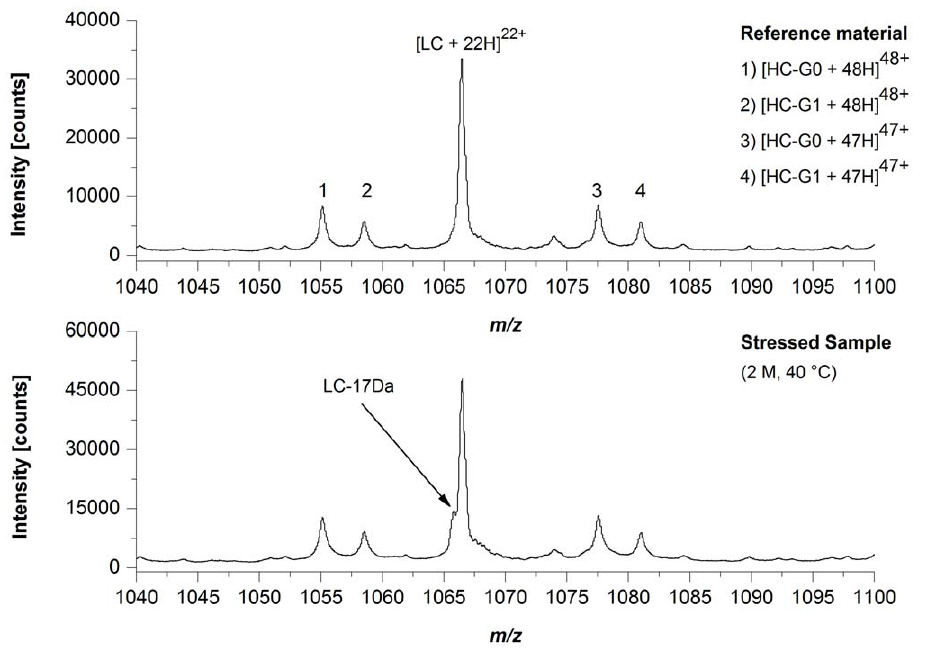
Figure 2. ESI-QTOF mass spectrometry of reduced HER2. NanoESI-QTOF mass spectra of HER2 reference material and HER2 stressed sample (stored at 40 u C for 2 month). The spectra were recorded in the positive ion mode using acetonitrile/water/formic acid (78/20/2, v/v/v) as solvent. LC, light chain; HC-G0, non-galactosylated heavy chain; HC-G1, mono-galactosylated heavy chain.